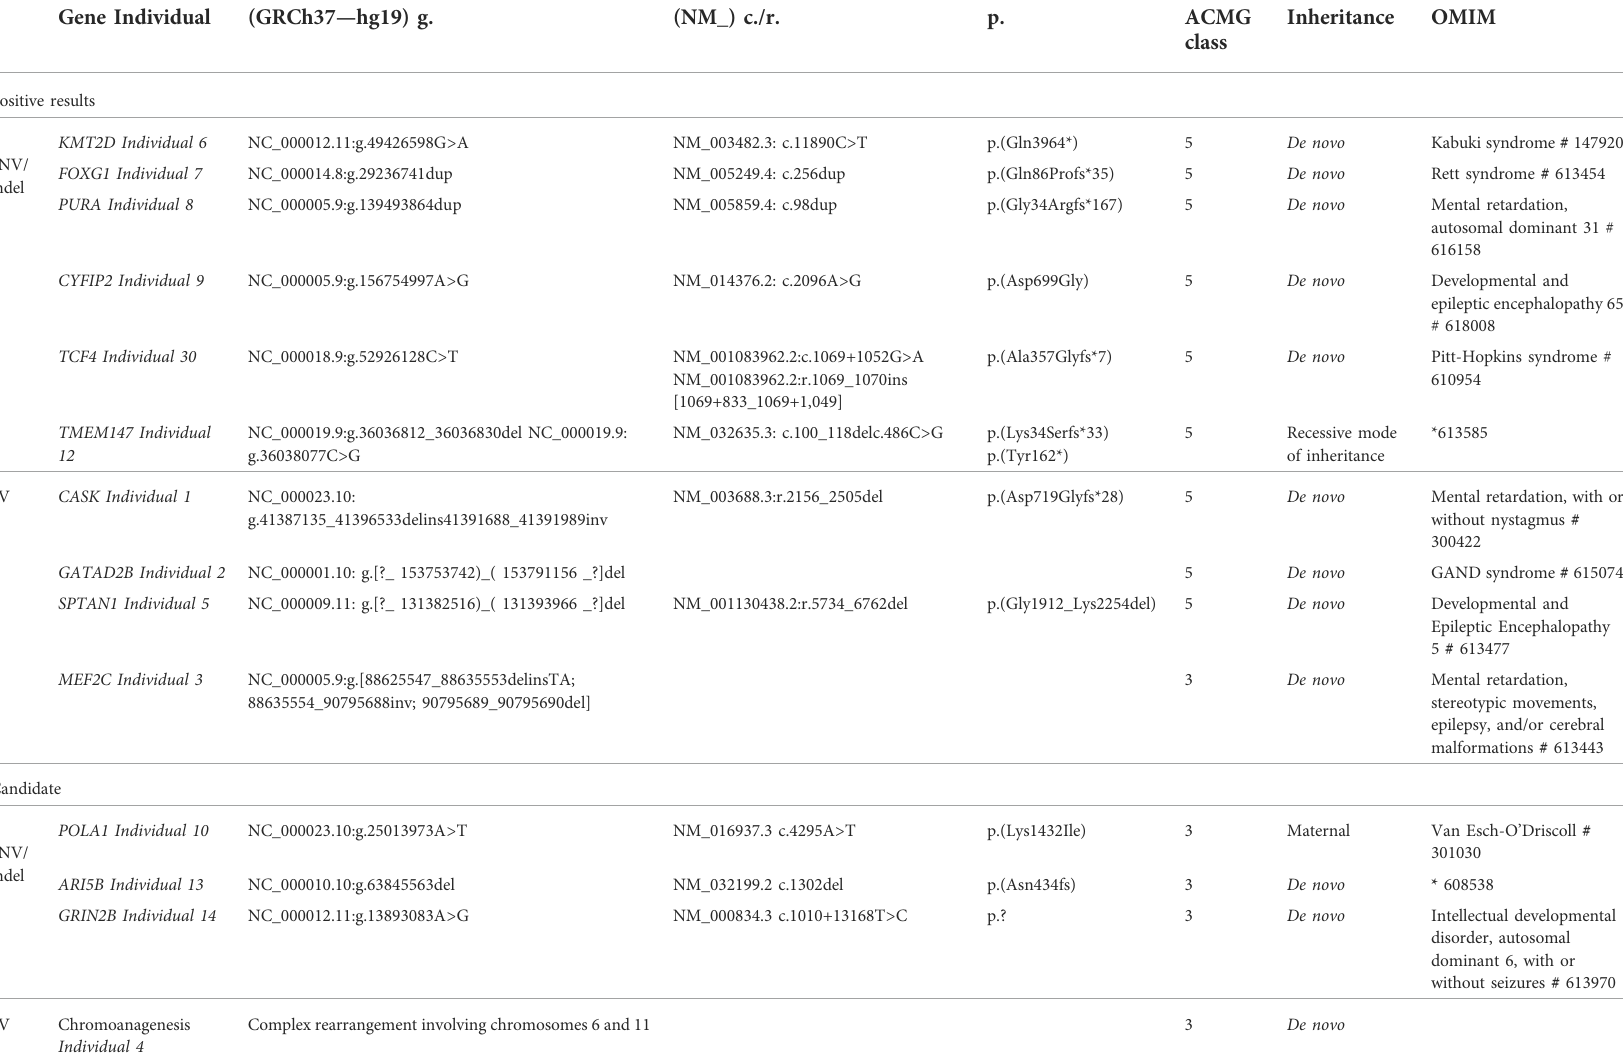
TABLE 1 Causative, candidate and excluded candidate genes of the cohort SNV, single nucleotide variant; indel, insertion-deletion; SV, structural variant. GRCh37-hg19 Genome Reference Consortium Human Build 37,NM_ c./r. Human Genome Variation Society nomenclature at the transcript or the RNA level p. nomenclature at the transcrip level ACMG American College of Medical Genetics and Genomics OMIM Online Mendelian Inheritance in